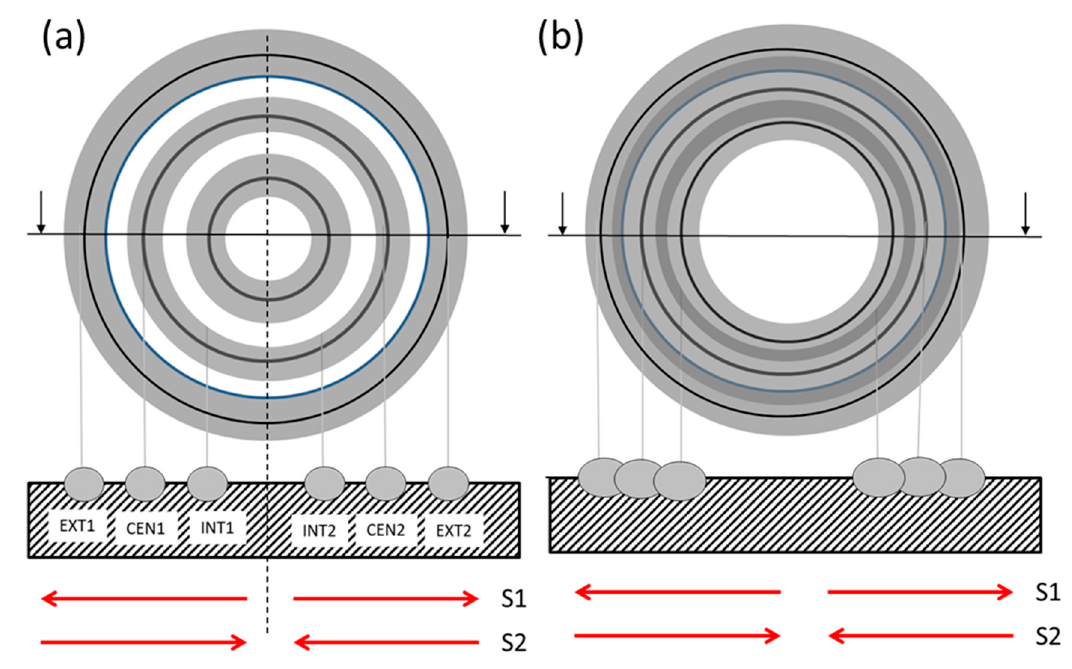
Figure 2. Schematic representation of ( a ) circular contour and ( b ) circular overlap sample.